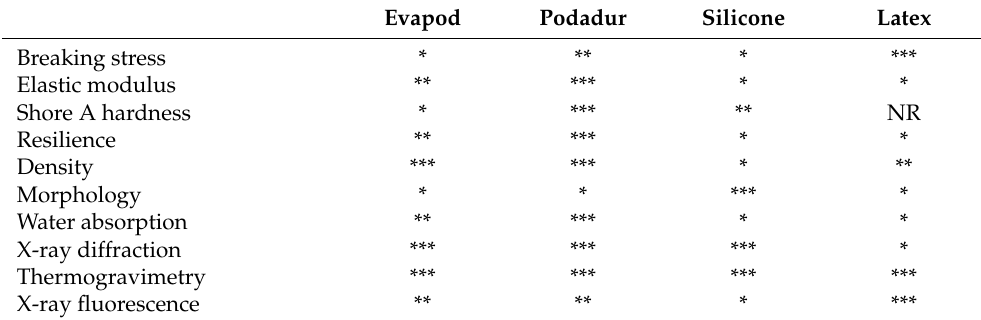
Table 4. Degree of recommendation for the development of orthopedic